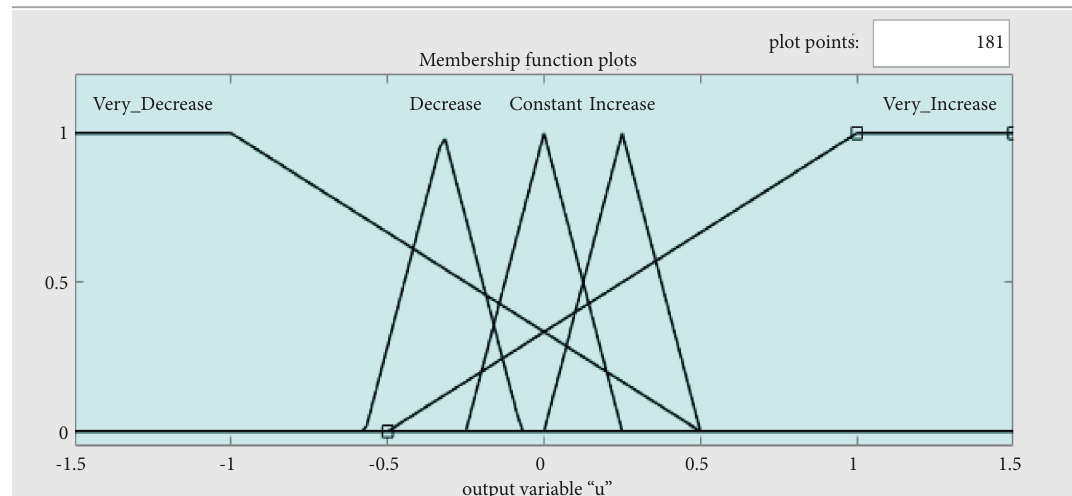
Figure 25: The output (u) Membership Functions.